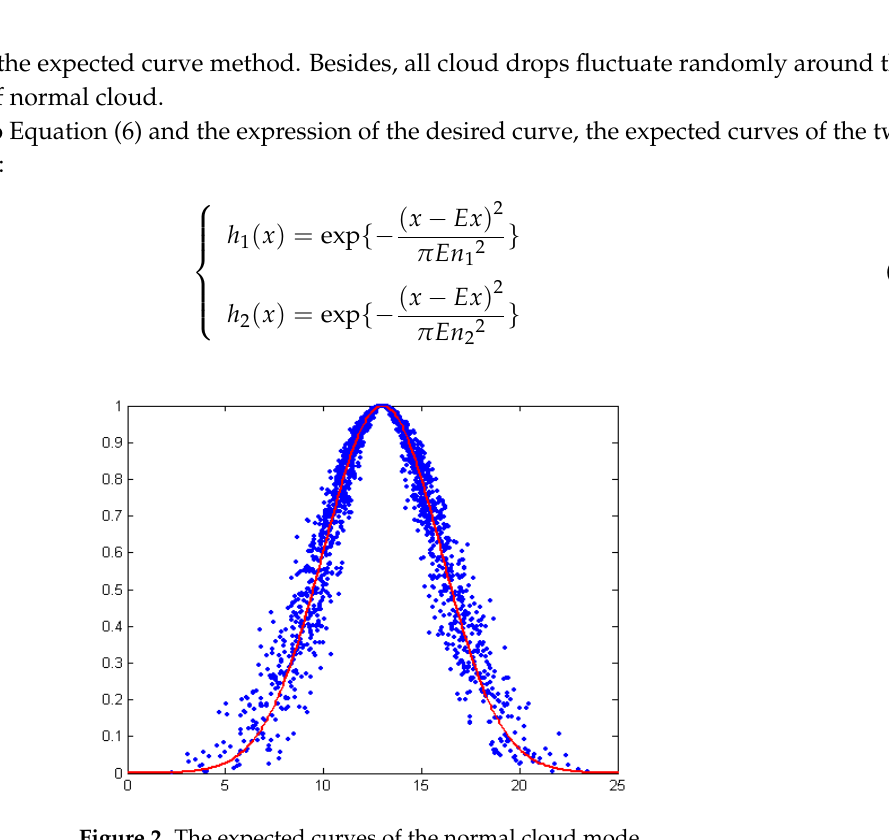
Figure 2. The expected curves of the normal cloud mode.